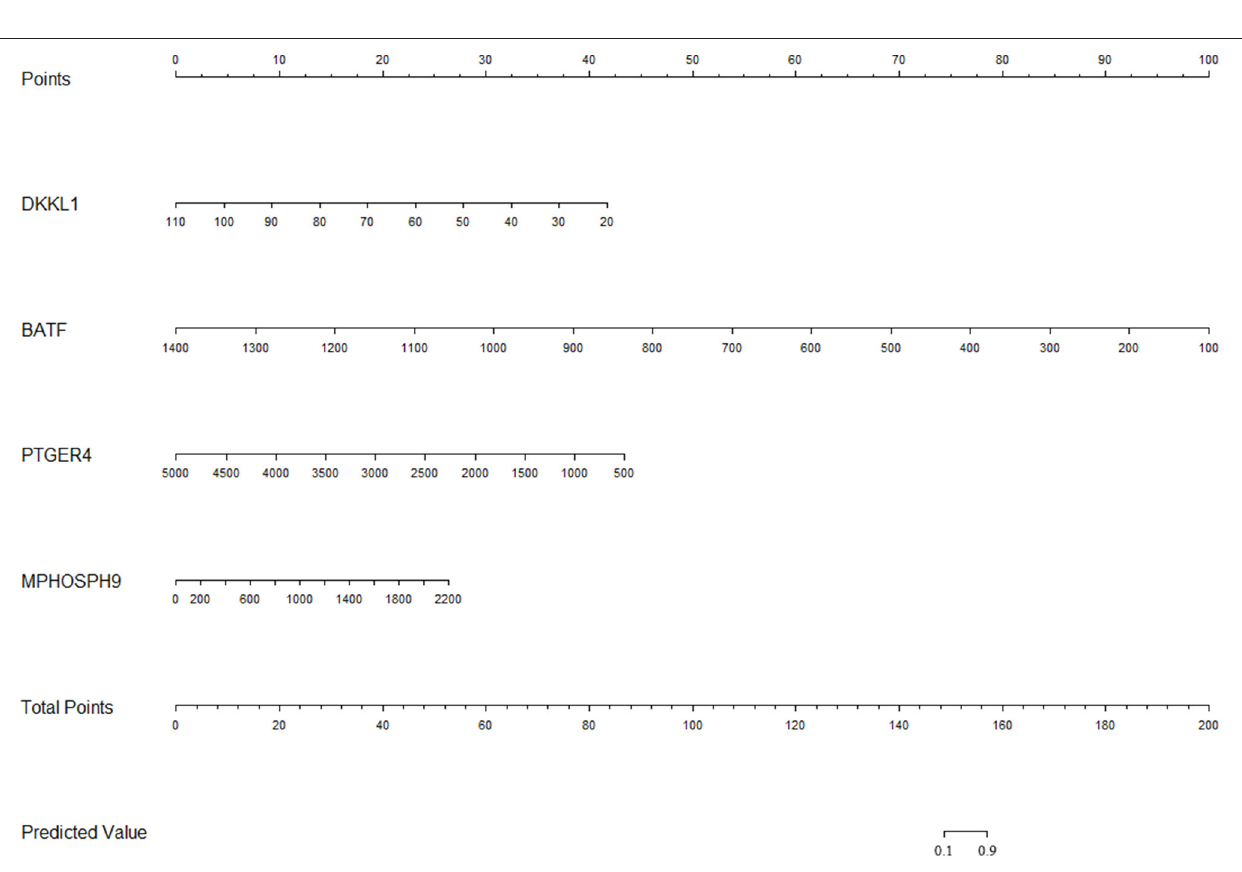
FIGURE 4 | The nomogram of the diagnosis model. Nomogram is a simple tool to calculate the output probability of the model. For more accurate probability calculation, please refer to the online prediction